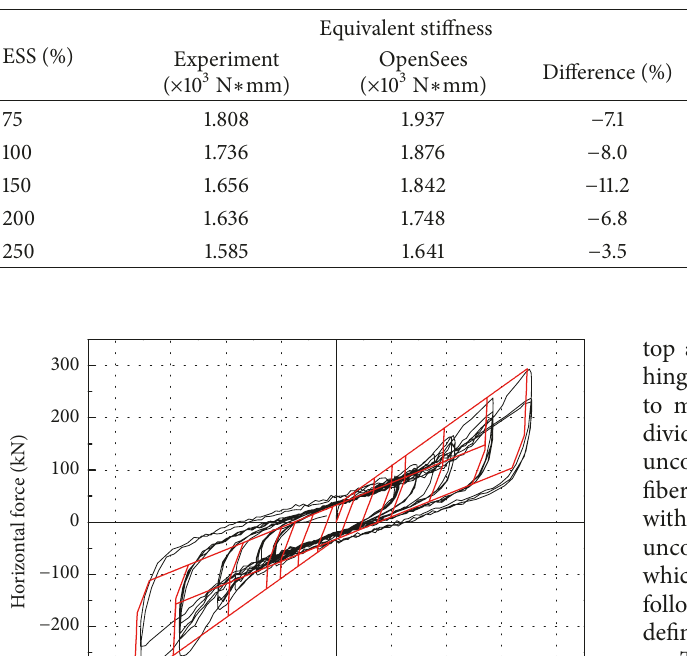
Figure 14: Analytical models of B-SLEBs. Table 5: Comparison of both the equivalent stiffness and damping ratio of specimen Y3-8/45-BB.